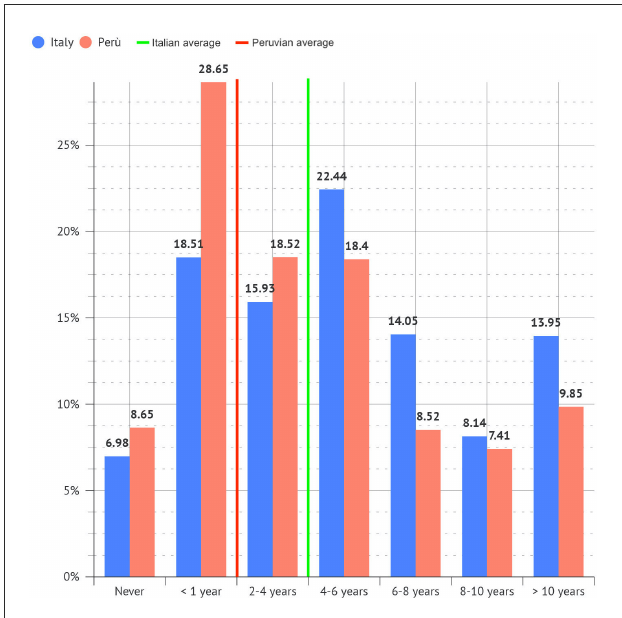
Pain—Drug consumption